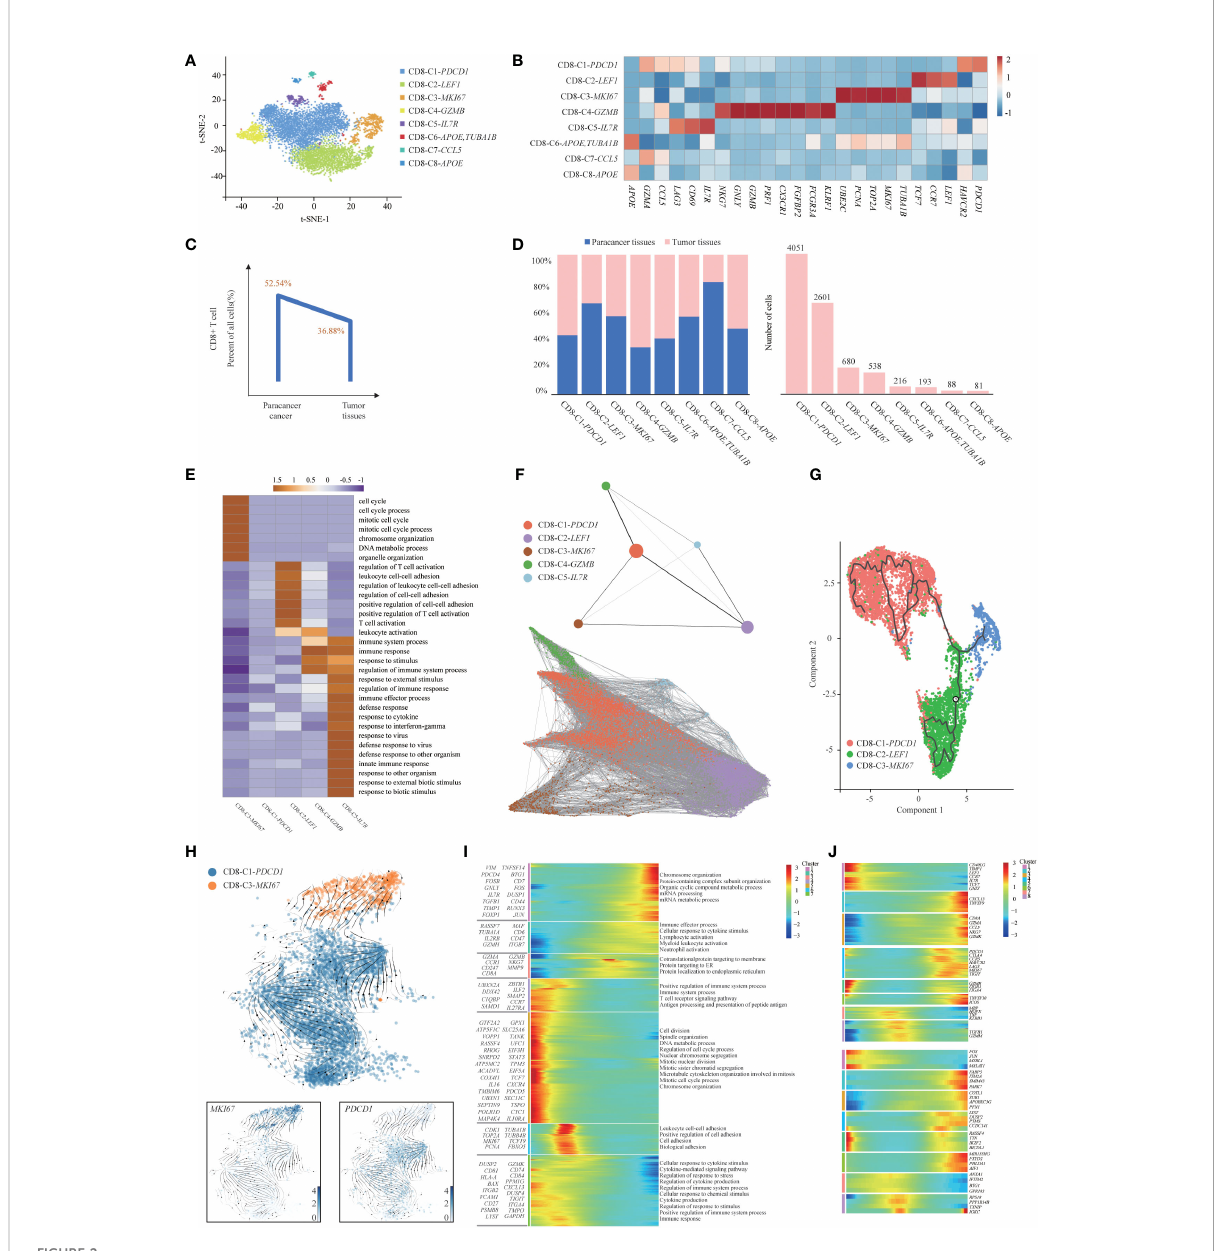
FIGURE 2 Gene expression heterogeneity of CD8 + T cell subsets was identi fi ed in the SUPS. (A) t-SNE plot showing the eight main subsets of CD8 + T cells. (B) Relative expression map of known marker genes associated with each cell subset. Mean expression values are scaled by mean- centering, and transformed to a scale from -1 to 2. (C) . The percentages of CD8 + T cells in paracancer tissues and tumor tissues. (D) The cell number and proportion of each CD8 + T cell cluster. (E) Functional enrichment analysis of upregulated genes in each CD8 + T cells cluster was performed with GO analysis. Representative signi fi cantly enriched function processes are shown. (F) Pseudotime trajectories for CD8 + T cells (CD8-C1- PDCD1 , CD8-C2- LEF1 , CD8-C3- MKI67 , CD8-C4- GZMB , CD8-C5- IL7R ) based on PAGA. (G) The Monocle 3 trajectory plot showed the dynamics of CD8-C1- PDCD1 , CD8-C2- LEF1 and CD8-C3- MKI67 . (H) RNA velocities are visualized on the UMAP projection of CD8-C3- MKI67 and CD8-C1- PDCD1 populations, colored by clusters. (I) The DEGs (in rows, q -value < 10 − 10 ) in CD8 + T cells along the pseudotime were hierarchically clustered into different subsets. The top annotated GO terms in each cluster were provided. (J) Gene expression dynamics along the CD8-C1- PDCD1 trajectory. Genes cluster into different gene sets, each characterized by speci fi c expression pro fi les (upper). For each gene cluster (indicated by different colors), the expression of some novel genes along the trajectory is shown